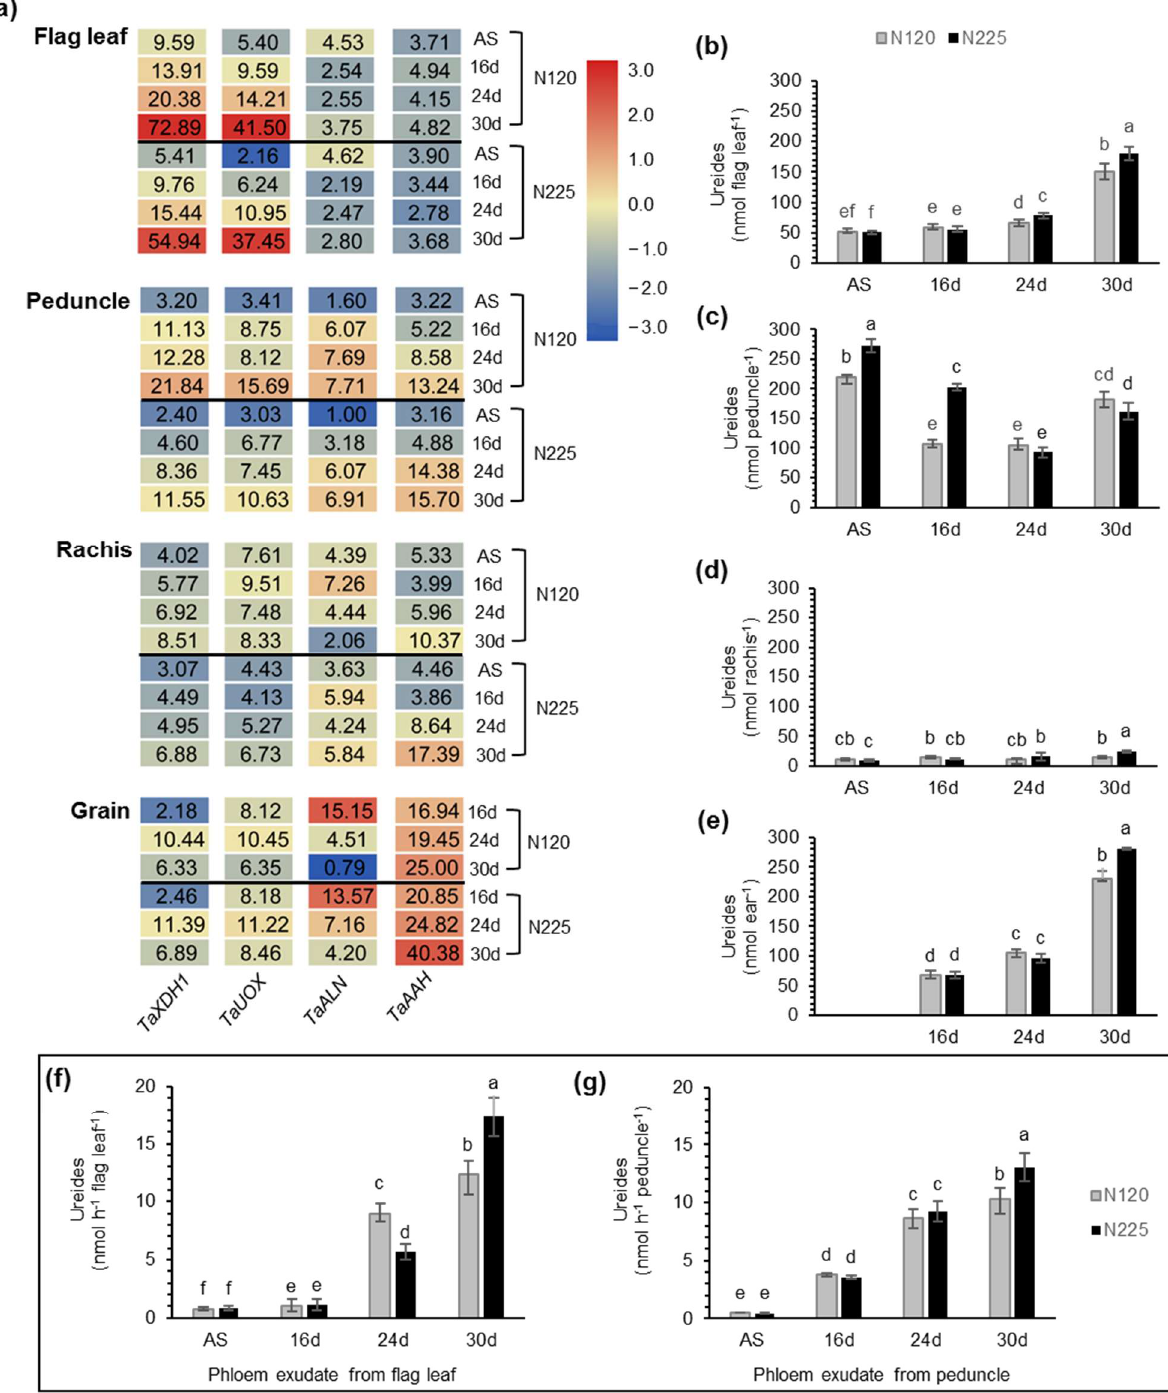
Figure 4. Characteristics of synthesis, transport, and degradation of ureides in wheat at the grain filling stage. ( a ) qRT-PCR analysis of the ureide metabolism genes in different organs in relation to N fertilization and development. The geometric mean of C t values of TaATPases and TaTEF served to normalize the expression ratio for each gene. Data in the figure are origin data and the means of six independent biological replicates. Gene expression data are shown as log 2 -transformed data of normalized data+1. Ureides accumulation in the flag leaf ( b ), peduncle ( c ), rachis ( d ), and ear ( e ) during grain filling grown under N120 and N225 conditions. The content of ureides in the phloem exudate of flag leaf ( f ) and peduncle ( g ) during grain filling grown under N120 and N225 conditions. Data are means of six independent biological replicates ± SD. The different letters above each sample indicate statistically significant differences, where p < 0.05 according to one-way ANOVA and Duncan post-hoc test.